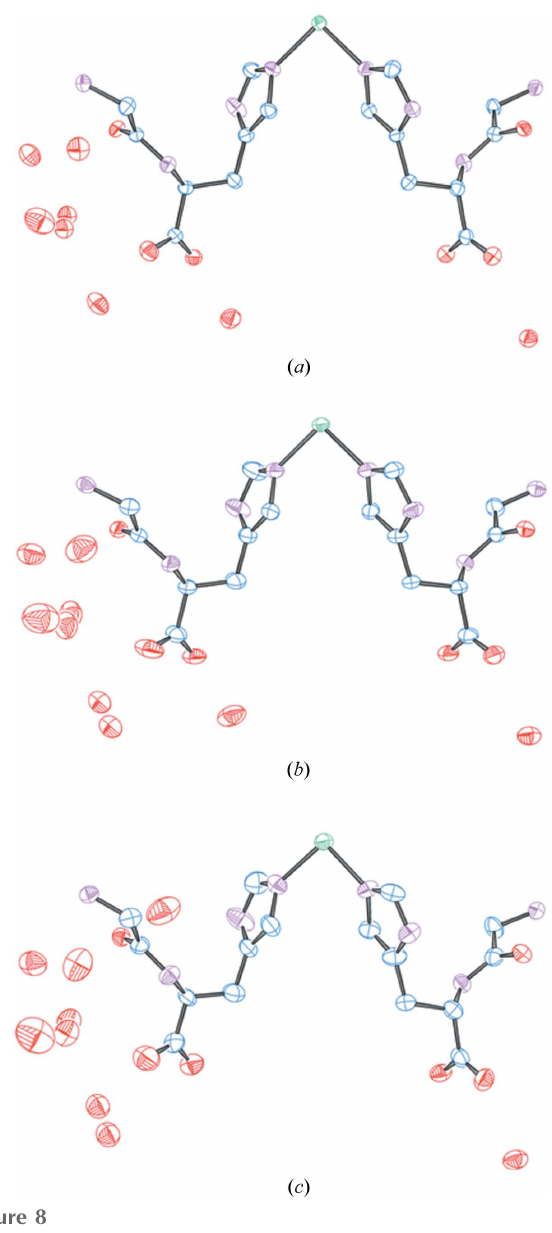
Figure 8 Comparison of structural models for the three data points [( a ), ( b ) and ( c )] indicated in Table 3. Carbon is shown in blue, nitrogen is shown in purple, oxygen is shown in red and nickel is shown in